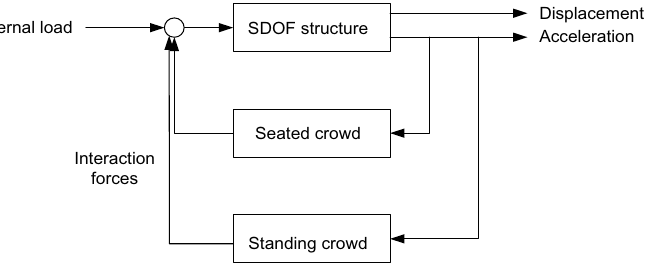
Fig. 3. Feedback system representation for the joint crowd-SDOF